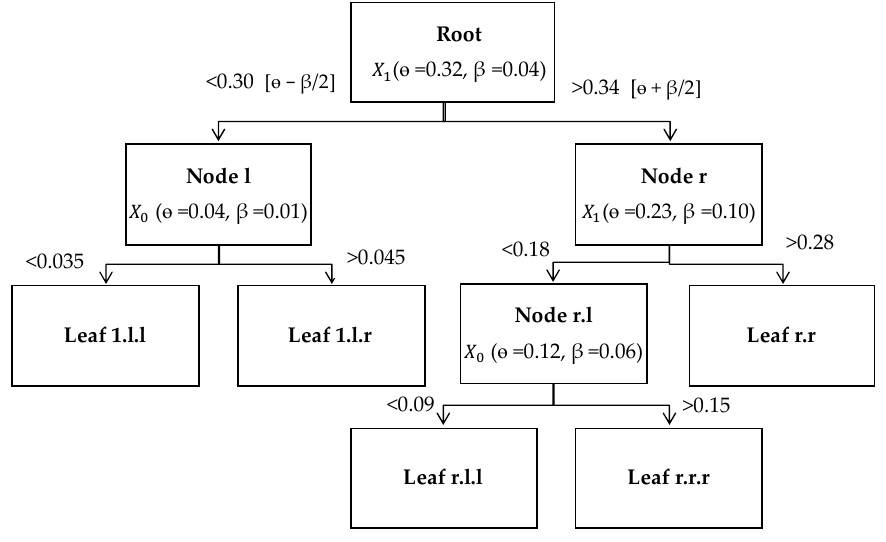
Figure 1. Example of a fuzzy survival tree (FST).